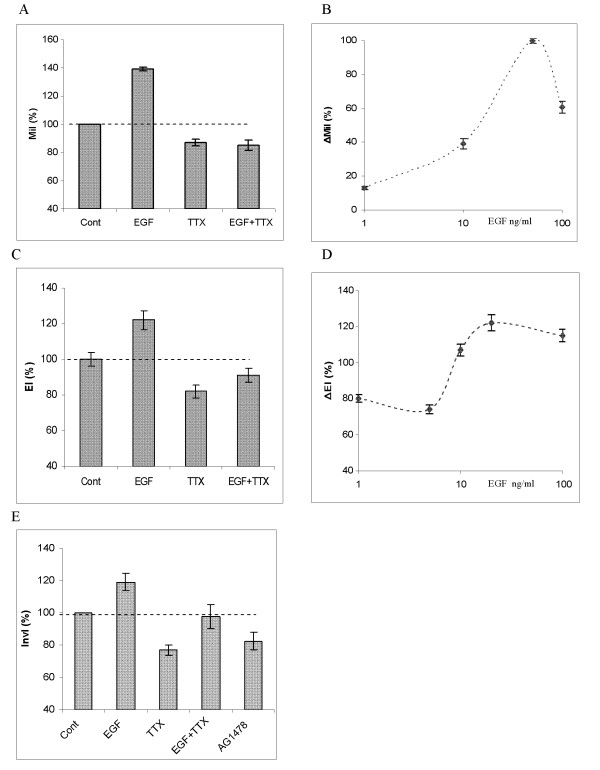
Functional evidence for EGF-induced enhancement of metastatic cell behaviours via VGSC expression/activity in PC-3M cells. (A) Migration index (MiI), expressed relative to the control level (Cont), fixed as 100 %. Effects of EGF (50 ng/ml), TTX (500 nM) and EGF+TTX are shown. (B) Dose dependence of the effect of EGF on MiI. ΔMiI denotes the percentage change (increase) in MiI induced by increasing concentrations of EGF, expressed relative to the maximum (fixed as 100 %) seen for 50 ng/ml. (C) Endocytosis index (EI), expressed as percentage of the control level (Cont). Effects of EGF (20 ng/ml), TTX (500 nM) and EGF+TTX are shown. (D) Dose dependence of the effect of EGF on EI. ΔEI denotes the change (increase) in EI induced by given concentrations of EGF. (E) Boyden chamber invasion assay data. Effects of EGF (100 ng/ml), TTX (500 nM), EGF+TTX and AG1478 (100 nM) are shown. Invasion index (InvI) denotes the percentage of cells crossing the membrane in Transwell assays. Each data point or histobar denotes mean ± standard error (n = 4).